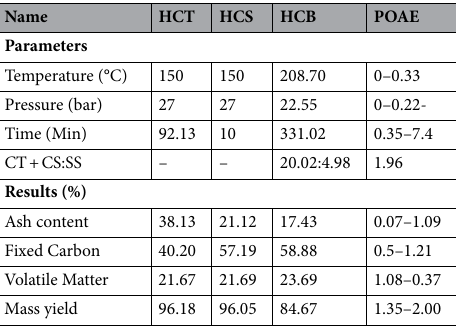
Table 6. Hydrothermal carbonization and co-hydrothermal carbonization optimum operating conditions. HCT coal tailing’s hydrochar, HCS coal slurry’s hydrochar, HCB hydrochar from the Co-HTC of coal and sewage sludge, SS sewage sludge, POE percentage of absolute error.